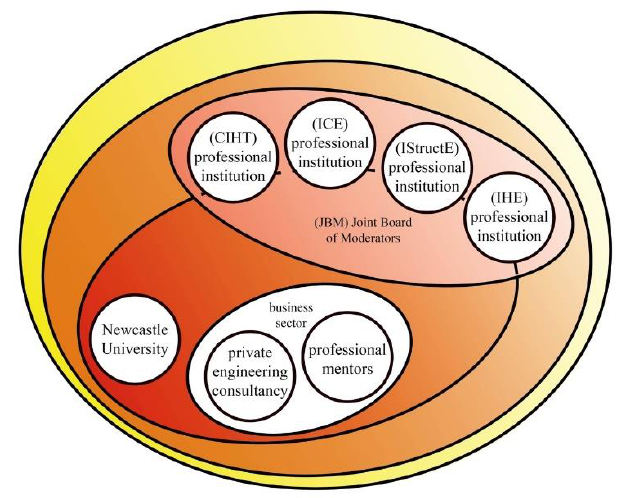
Figure 9. Mapping of Design of Sustainable Engineering Systems Undergraduate Level 5/6 Module.